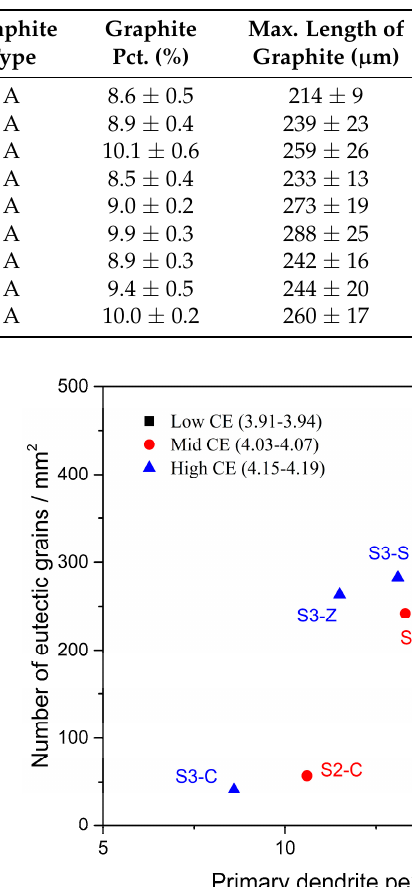
Table 2. Microstructural characteristics of samples. Errors are ± one standard deviation.